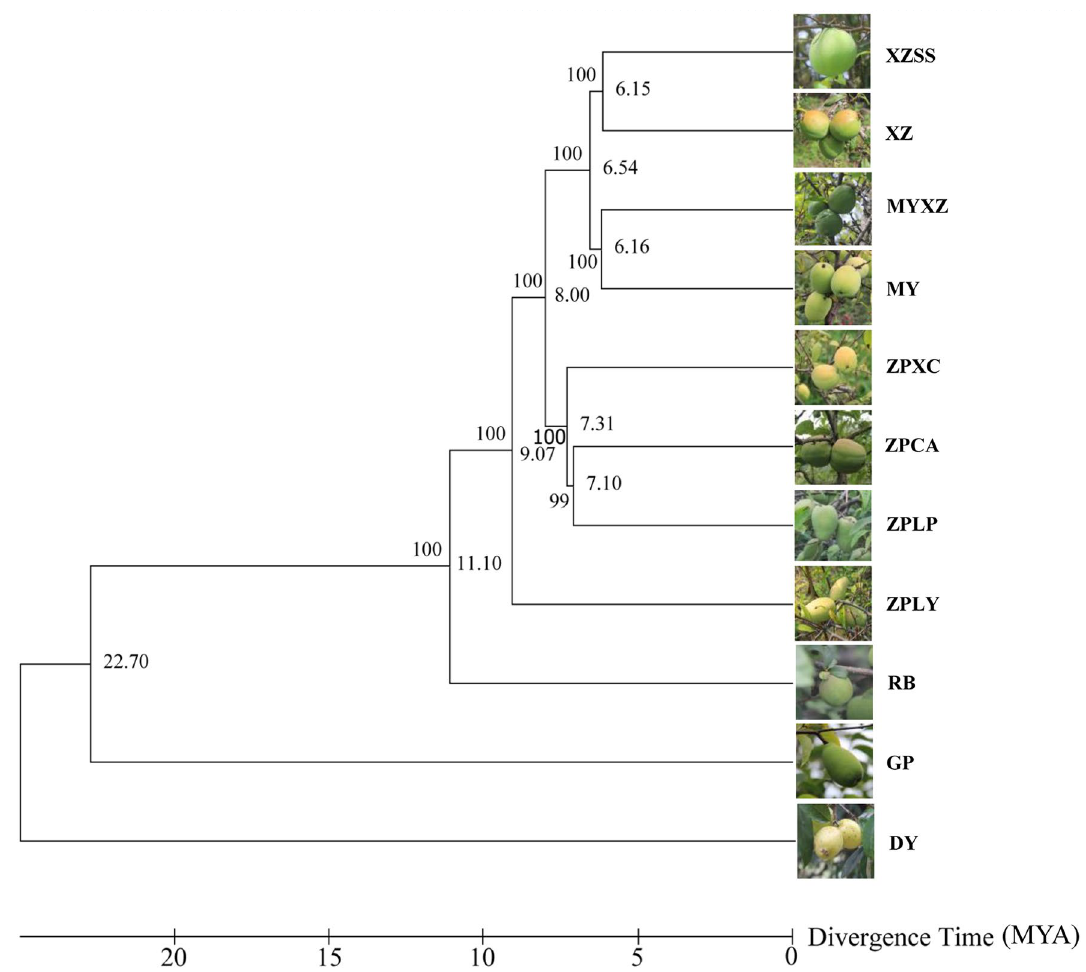
Figure 4. Phylogenetic tree based on common single-copy genes of the 11 germplasms. Numbers to the left of the nodes are bootstrap values; numbers to the right of the nodes are divergence times. MYA is short for million years ago. Evolutionary tree were conducted in MEGA X